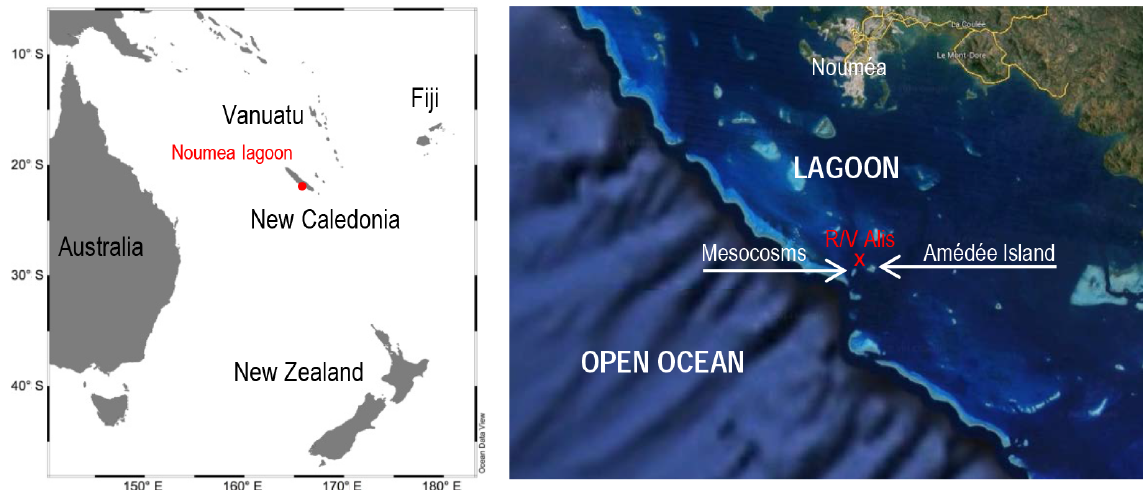
Figure 1. Position of mesocosms implemented in the south-west lagoon of New